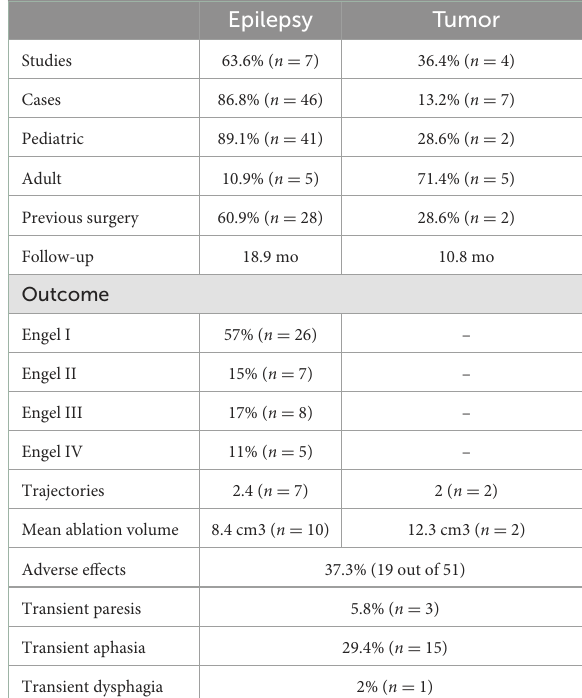
TABLE 1 Characteristics of the patients treated with insular LITT according to reported